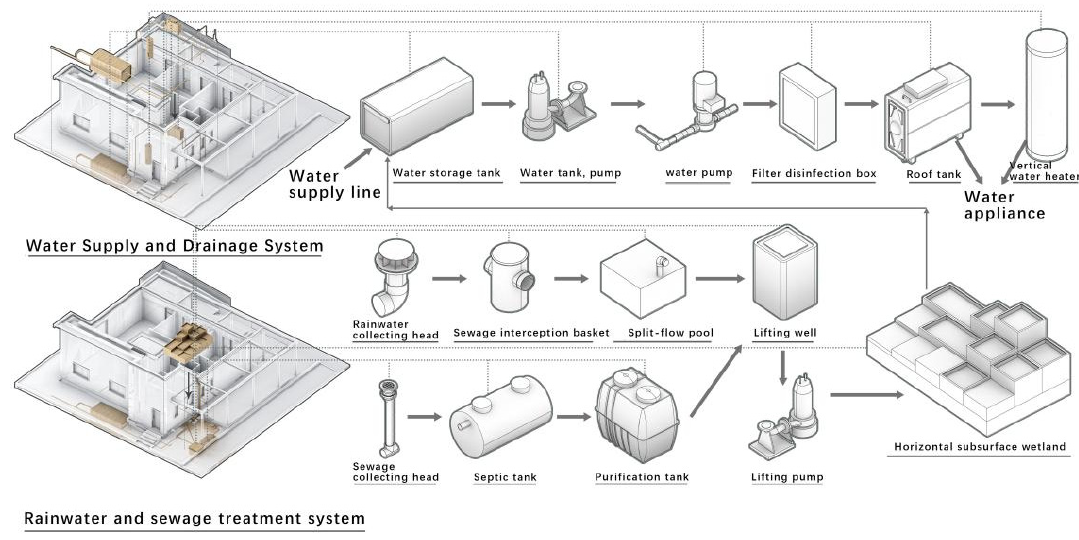
Figure 21. BIM model of water treatment system.